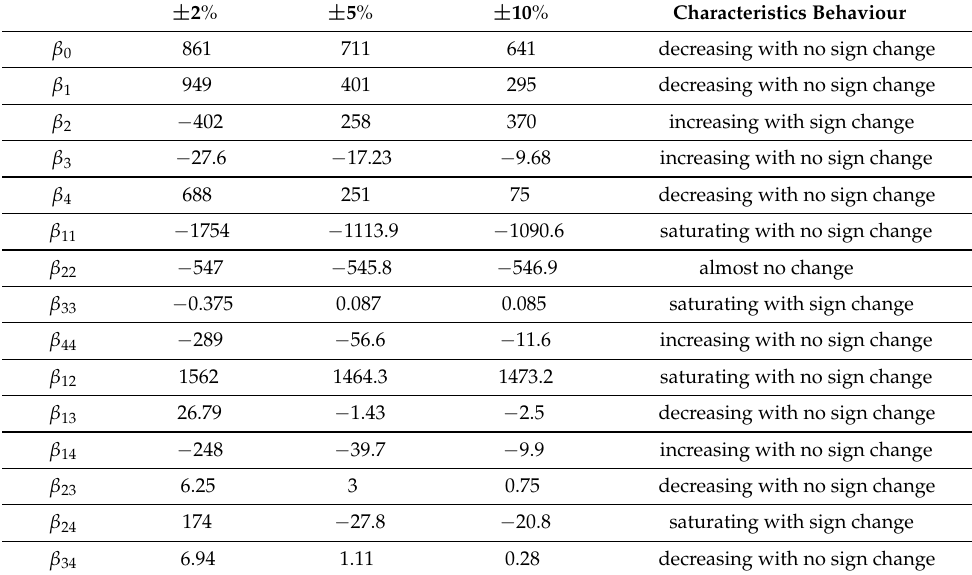
Table 10. The coefficients of RPW model equations with tolerance levels corresponding to HC- PCF structural parameter value variations of ± 2% (Equation (11)), ± 5% (Equation (12)) and ± 10% (Equation (13)). ± 2 % ± 5